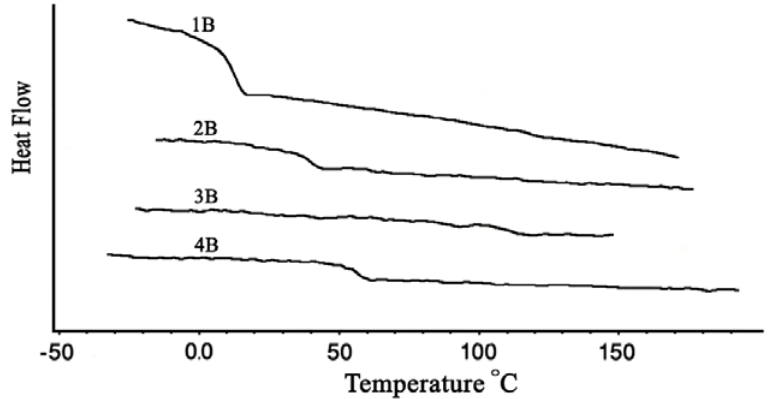
Figure 6 . DSC Thermograms of polycarbonates (Series